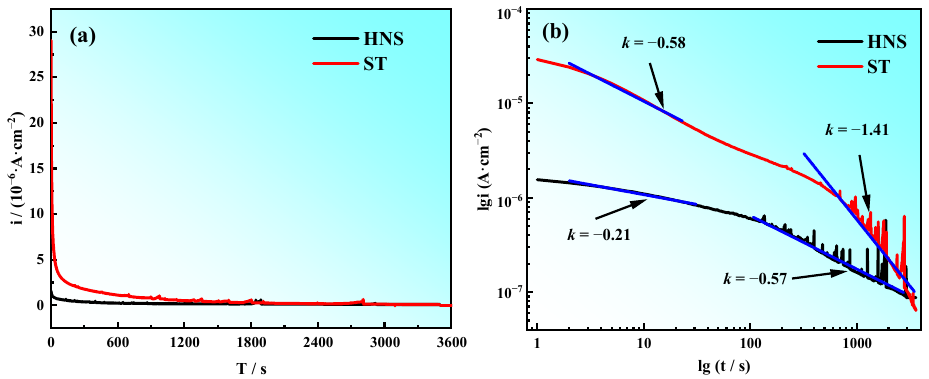
Figure 8. ( a ) Current–time curves; and ( b ) double-log plots of current–time for HNS and ST.